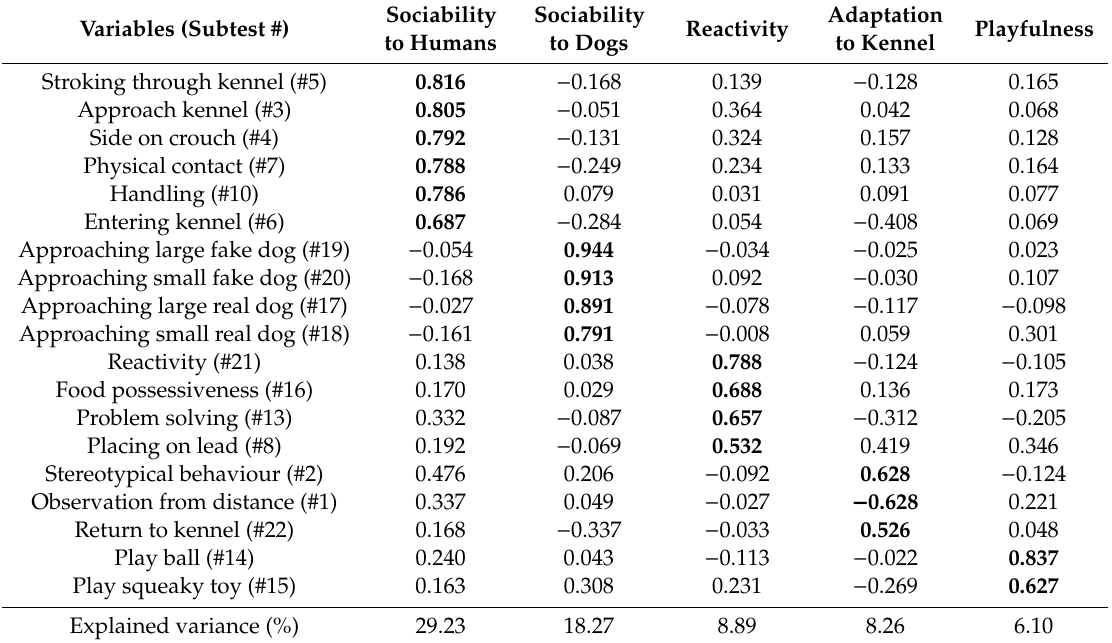
Table 1. Dimensions extracted by the principal component analysis (PCA). Loadings higher than 0.50 are in bold.